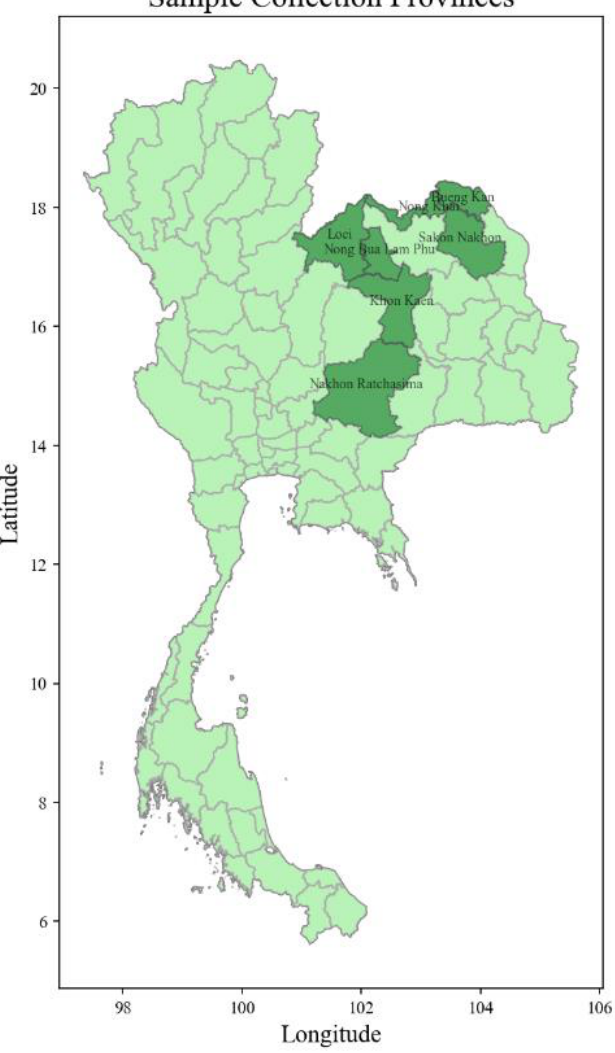
Figure 1. Study areas include Loei, Nong Bua Lam Phu, Khon Kaen, Nakhon Ratchasima, Nong Khai, Bueng Kan, and Sakon Nakhon provinces of Thailand. The unit for latitude and longitude is degree ( ◦